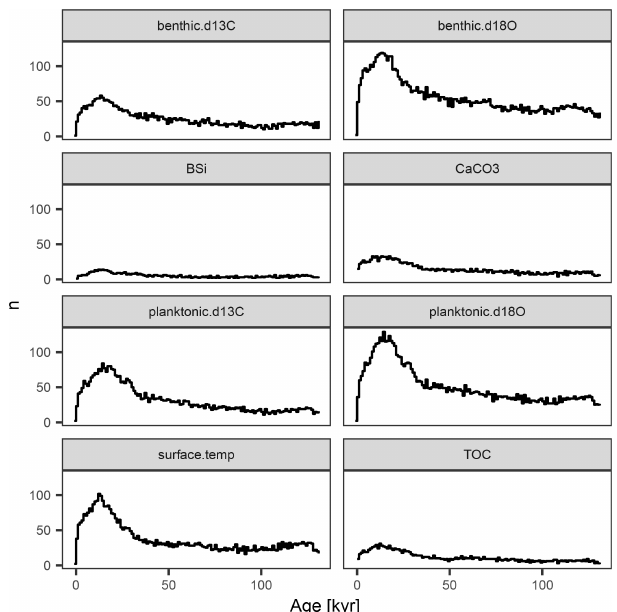
Figure 4. Temporal distribution of time series in version 1.0.0 of the PalMod 130k marine palaeoclimate data synthesis. The number of time series ( y axis) is counted per 1000-year bin. The tempo- ral availability of all parameters shows a clear maximum around 15ka, reflecting the research focus on the last glacial termination. For benthic foraminifera δ 13 C, only time series with data based on the genus Cibicidoides are shown.